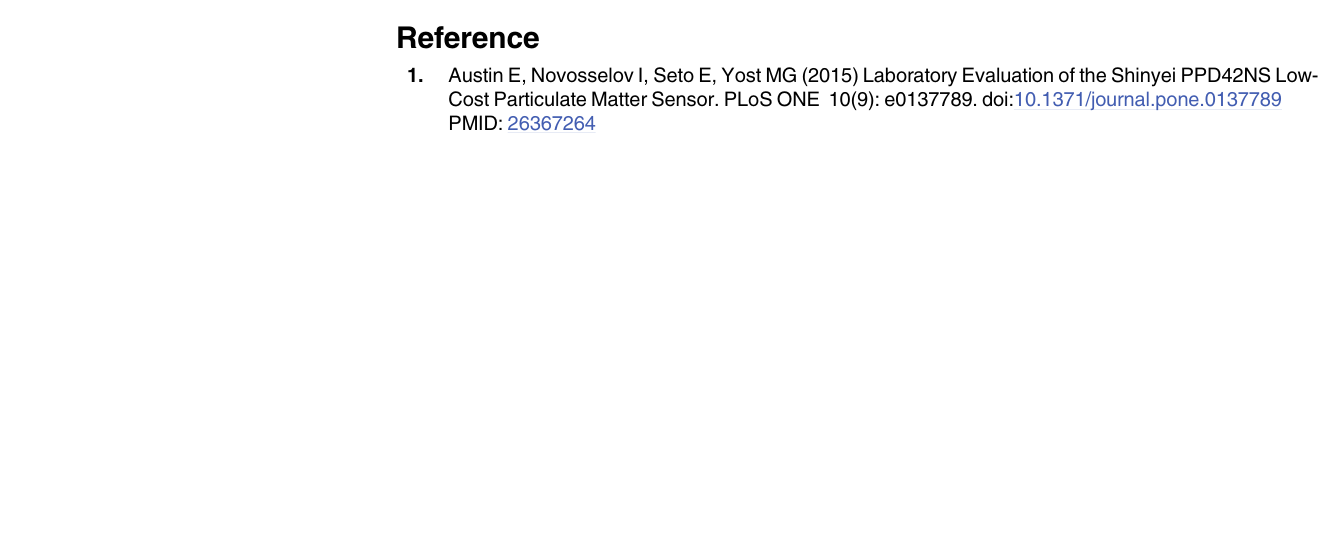
Fig 5. Bland Altman Plots (4 sensors pooled together). The red dashed lines represent a 10% error on the mass measurement. The black vertical dashed line represents the LOD.